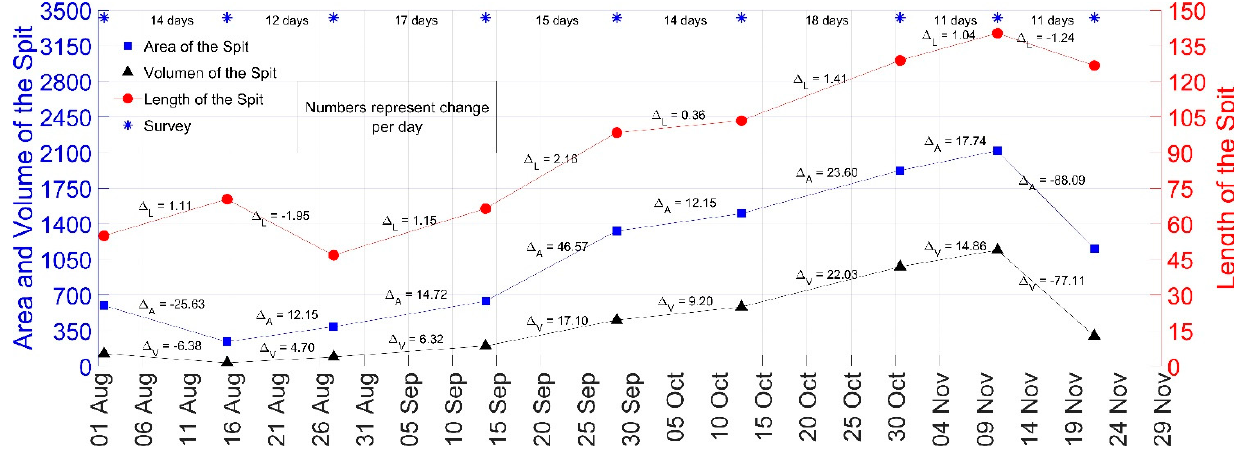
Figure 7. Computed length (m), area (m 2 ), and volume (m 3 ) during the eight periods of the study. Δ L (m/day), Δ A (m 2 /day), and Δ V (m 3 /day) represent the daily rate of change during each period.